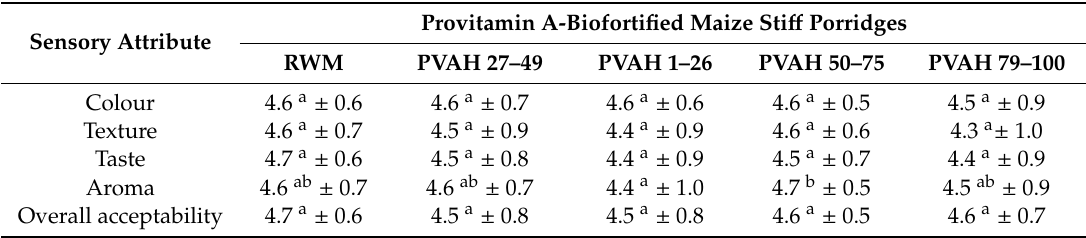
Table 5. Sensory acceptability of provitamin A-biofortified maize sti ff porridges. Sensory